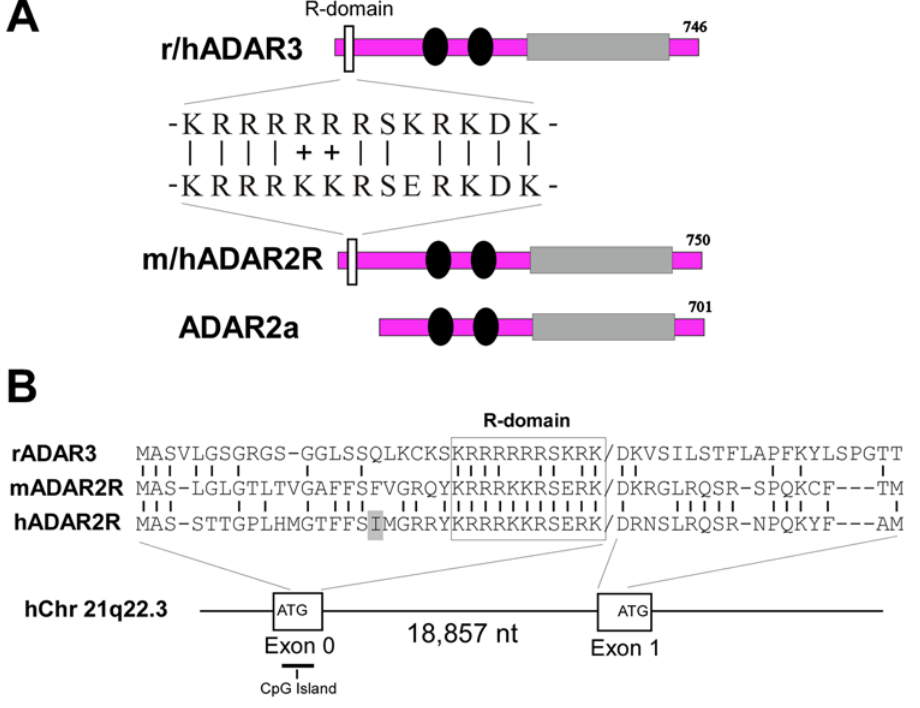
Figure 2. Comparison of ADAR2R with ADAR3 R-domain. A) Comparison of the rat and human ADAR3 protein with the mouse and human ADAR2R protein variant. Includes sequence alignment of ADAR3 R-domain and the putative R-domain of ADAR2R. Black circles: dsRNA binding domain, shaded rectangles: catalytic deaminase domain. B) Alignment of the rat ADAR3 N-terminal region and the translated sequence of the mouse and human ADAR2R N-terminus. The R-domain sequence is boxed and identical amino acids are indicated by a vertical line. Below a schematic representation of the relative position of exon 0 on human Chromosome 21 at the ADAR2 gene locus. The grey-colored Isoleucine residue (I) in hADAR2R represents the position of a recoding SNP that leads to a I-to-V change.